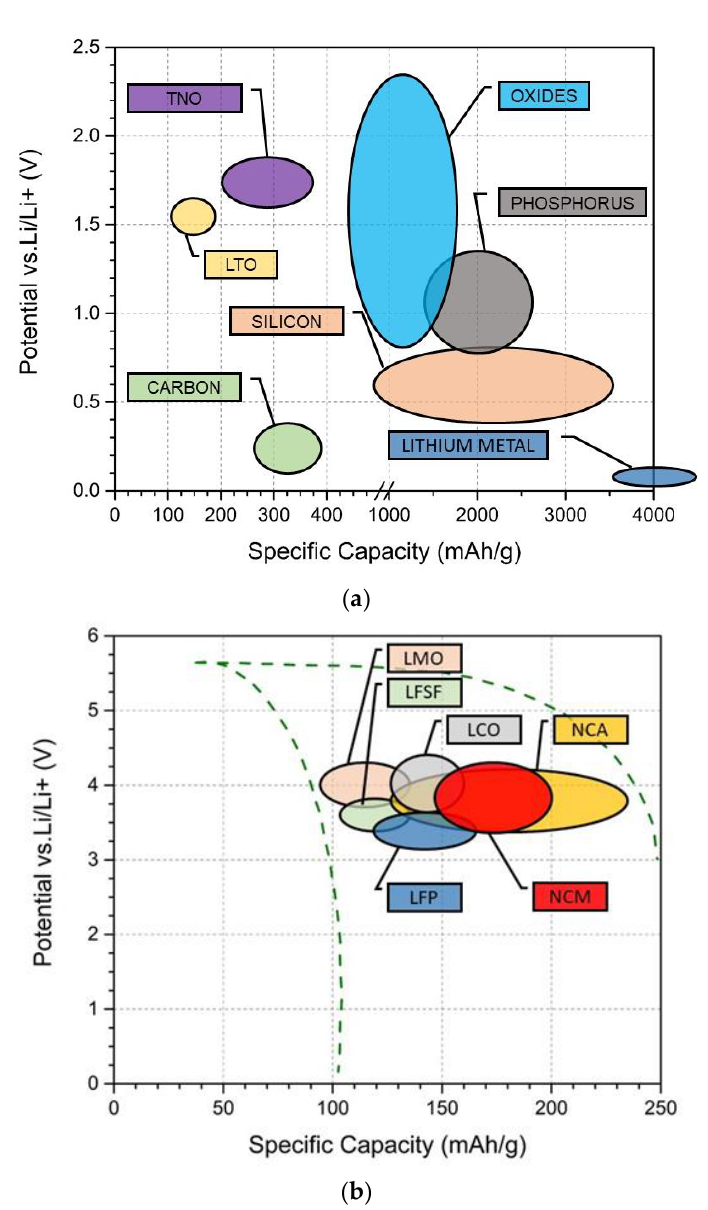
Figure 2. Discharge potential v/s specific capacity of some commonly used ( a ) anode and ( b ) cathode materials. Reproduced with permission from ref. [28]. Copyright 2014. Nitta, N., Wu, F., Lee, J.T., Yushin, G.; published by Elsevier Ltd.